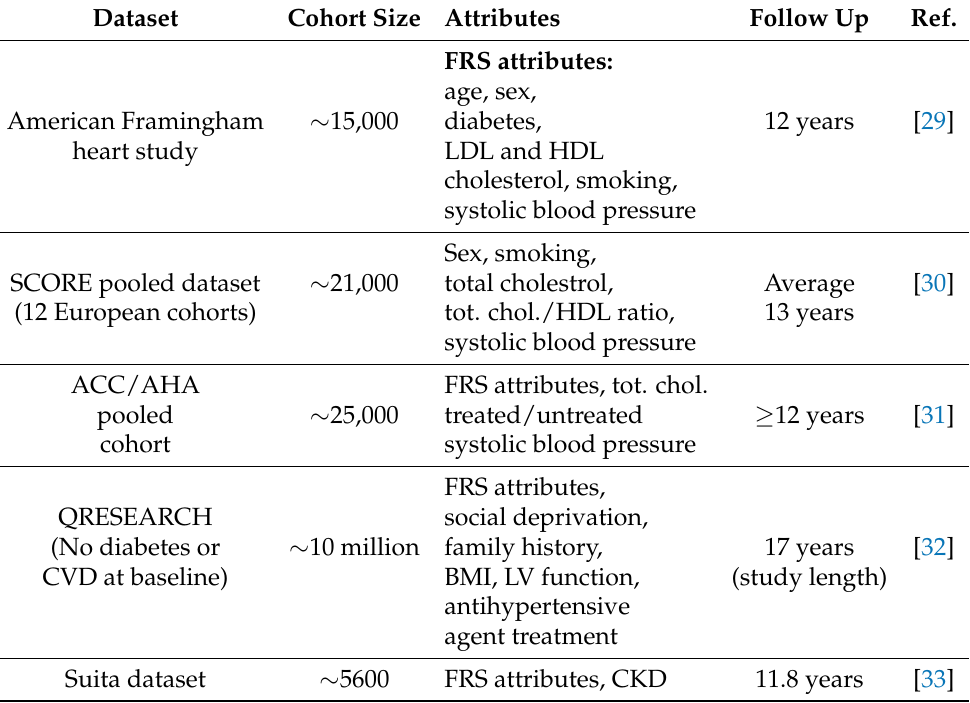
Table 1. Table of clinical datasets used to train traditional risk scores. LDL—Low-density lipid; HDL—High-density lipid; BMI—Body mass index; LV—Left ventricle; CKD—Chronic kidney